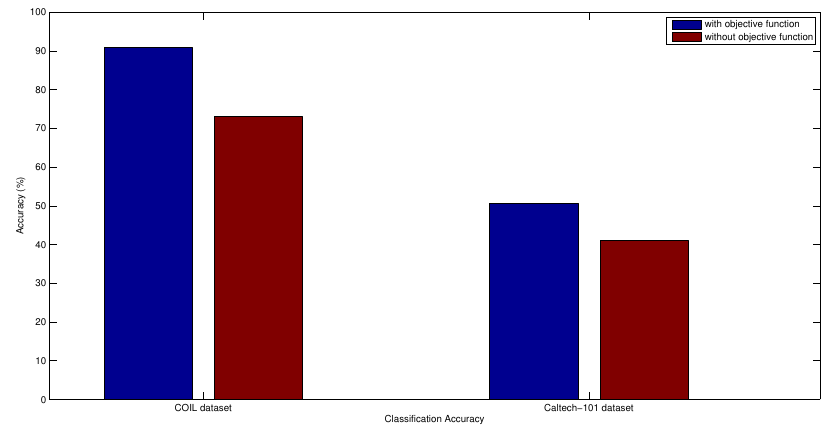
Figure 13. Average accuracy over COIL and Caltech-101 datasets.